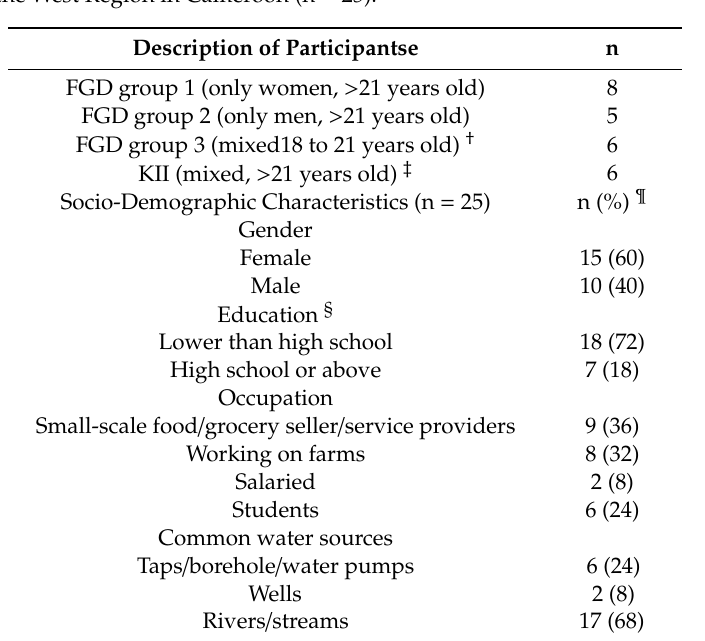
Table 1. Socio-Demographic Characteristics of Focus Group Discussion and Key Informant Interview Participants in the West Region in Cameroon (n =